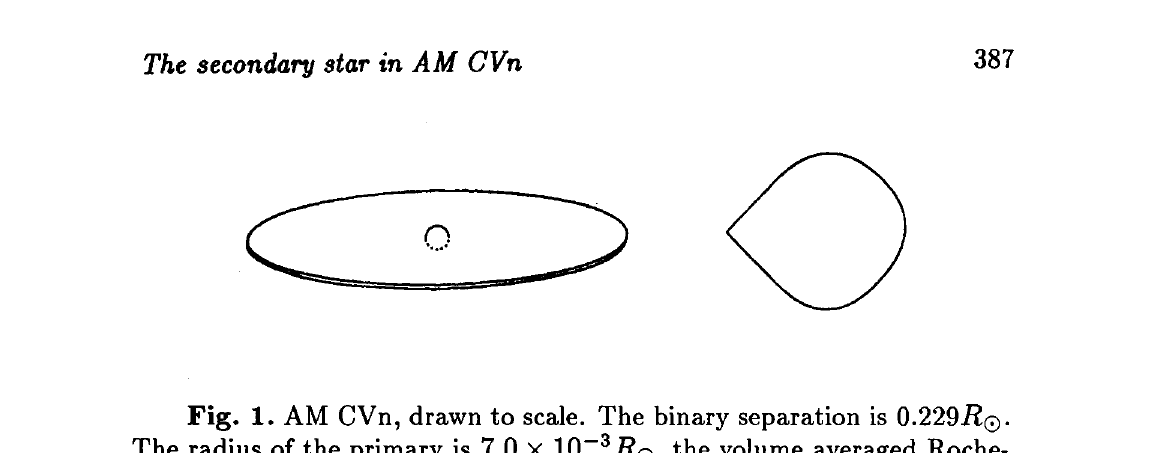
Fig. 1. AM CVn, drawn to scale. The binary separation is 0.229/2©. The radius of the primary is 7.0 X 1 0 - 3 R Q, the volume averaged Roche- lobe radius of the secondary is 0.045 RQ and the distance from the center of the secondary to the inner Lagrangian point is 0.059 RQ. The disc has a tidal radius of 0.11 RQ and its thickness at the edge is 2.6 X 10 _3 i2©. The secondary is assumed to be